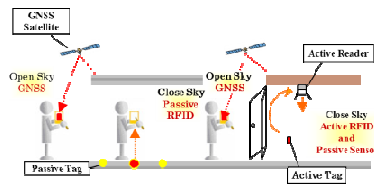
Figure 12. Concept of